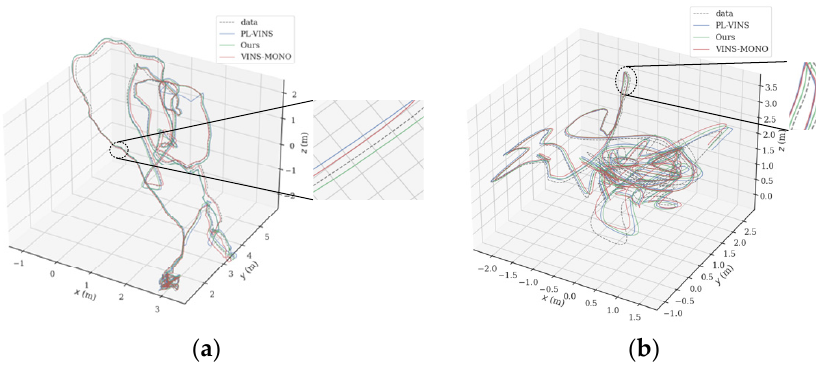
Figure 8. Comparison of trajectories of VINS-Mono, PL-VINS, and PLI-VINS in industrial factories and indoor rooms. The gray dashed lines are the trajectory truth value, and the blue, green and red solid lines are PL-VINS, the proposed PLI-VINS and the VINS-Mono: ( a ) sequence MH_01_easy scene respectively; ( b ) sequence V1_03_difficult scenario.